Question: Compose a caption that would accompany this figure in a paper.
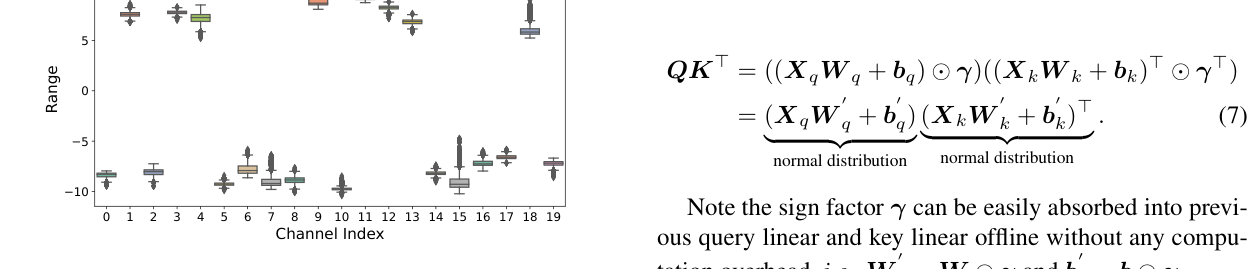
Answer: Boxplot of different channels of post-Key-Linear activations in SAM.